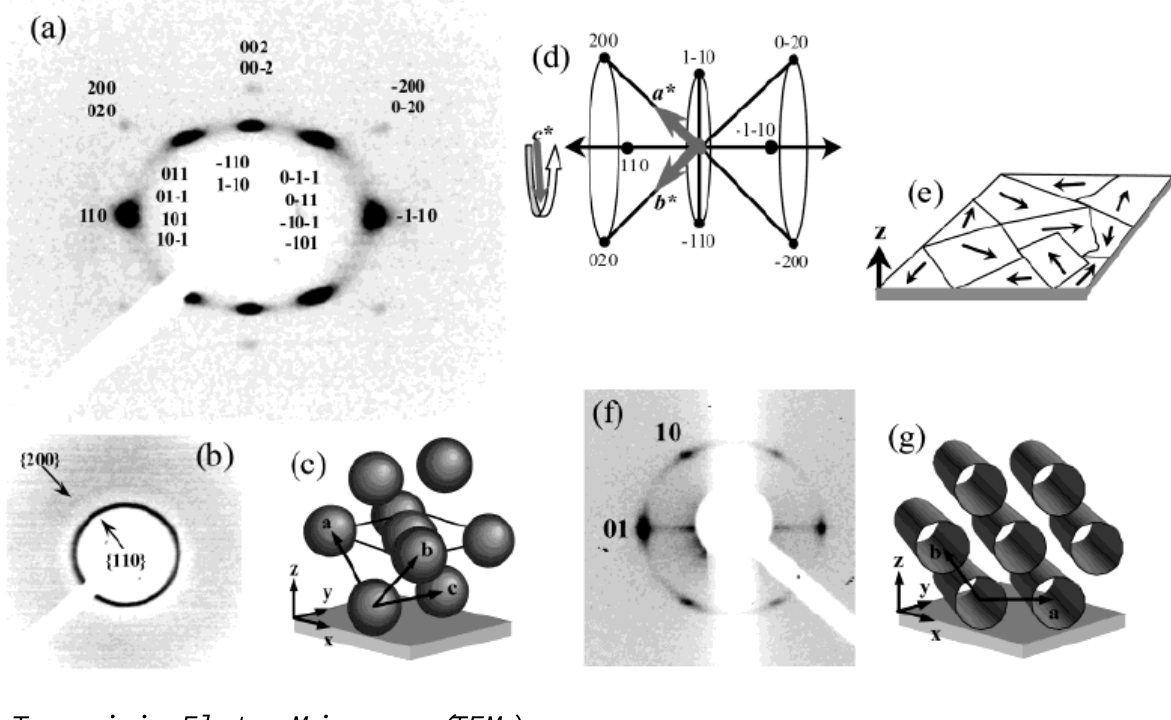
Figure 14. ( a ) Small Angle X-ray Scattering (SAXS) pattern collected at incident angles of ( a ) 4°; ( b ) 90° of a cubic TiO film; ( c ) representation of a cubic domain; ( d ) reciprocal 2 space; ( e ) representation of film orientation; ( f ) SAXS pattern of a hexagonal film; and ( g ) alignment of 2-D domains. Reprinted with permission from [62]. Copyright 2003 American Chemical